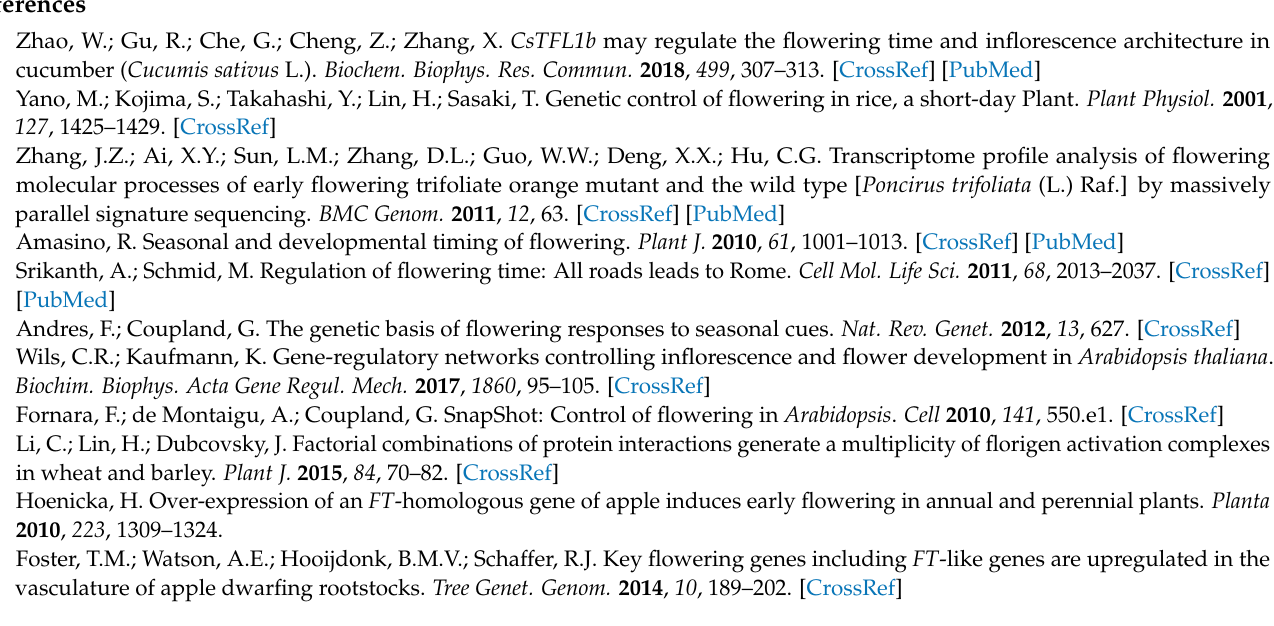
horizontal axis indicates sampling dates, i.e., 7–13, 7–19, 7–27, 8–03, 8–10, 8–17, and 8–24, respectively. Figure S7: The gene expression differences between ‘Baiyu’ and ‘Huoju’. Figure S8: Transcription factors distribution in loquat. Figure S9: GO enrichment of Huoju_713-vs-Baiyu_713. Figure S10: GO enrichment of Huoju_719-vs-Baiyu_719. Figure S11: GO enrichment of Huoju_727-vs-Baiyu_727. Figure S12: GO enrichment of Huoju_803-vs-Baiyu_803. Figure S13: GO enrichment of Huoju_810- vs-Baiyu_810. Figure S14: GO enrichment of Huoju_817-vs-Baiyu_817. Figure S15: GO enrichment of Huoju_824-vs-Baiyu_824. Table S1: Linear regression of ABA and IAA measured by LC-MS. Table S2: Primers for qRT-PCR analysis used in this study. Table S3: Matching of unigenes obtained by RNA-Seq data against genome database of loquat. Table S4: Unigene annotation based on GO enrichment. Table S5: Unigene annotation based on KEGG enrichment. Table S6: List of all DETs information with unigene ID, functional annotation and FPKM value. Table S7: The 42 candidate unigenes involved in flowering. Table S8: The 23 candidate unigenes involved in ABA signaling. Table S9: Transcription factors distribution in Huoju_713-vs-Baiyu_713. Table S10: Transcription factors distribution in Huoju_719-vs-Baiyu_719. Table S11: Transcription factors distribution in Table S13: Transcription factors distribution in Huoju_810-vs-Baiyu_810. Table S14: Transcription factors distribution in Huoju_817-vs-Baiyu_817. Table S15: Transcription factors distribution in